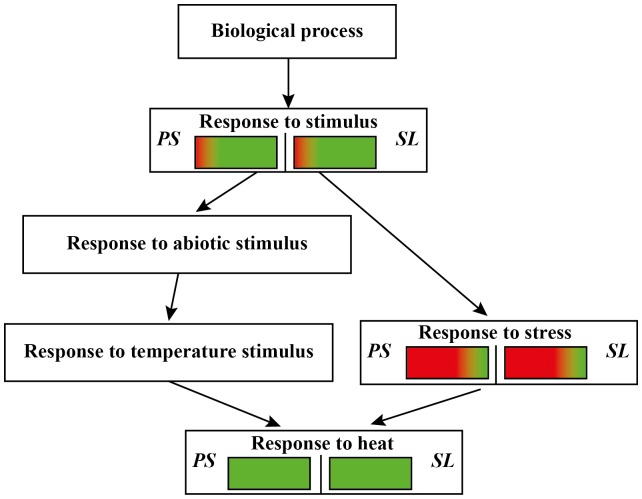
GO analysis of Arabidopsis commonly expressed genes upon Pseudomonas syringae (PS) infection and Spodoptera littoralis (SL) herbivory.Red color indicates up-regulation, green color indicates down-regulation.